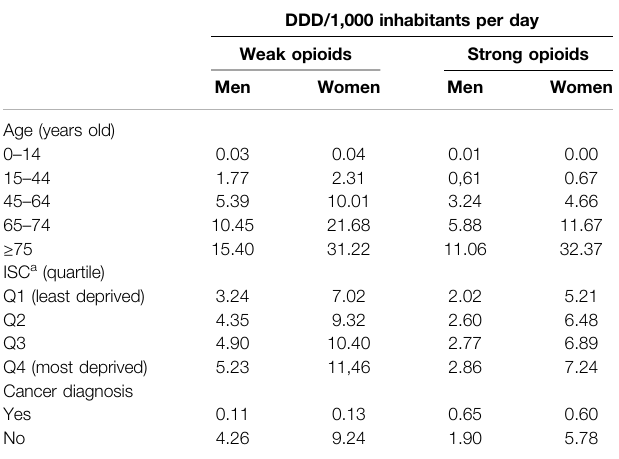
TABLE 2 | Opioid use (DDD/1,000 inhabitants per day) according to composite socioeconomic index, age, sex, and clinical diagnosis according to type of drug in Catalonia, 2019.